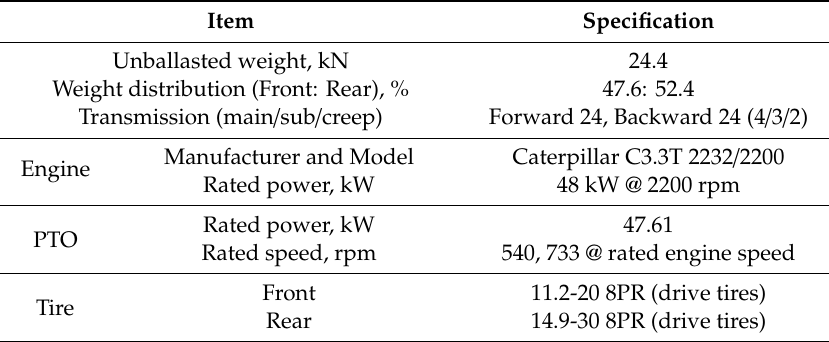
Figure 2. Block diagram of tractor dynamic model. Table 1. Specifications of MFWD tractor used for modelling in this study [7].